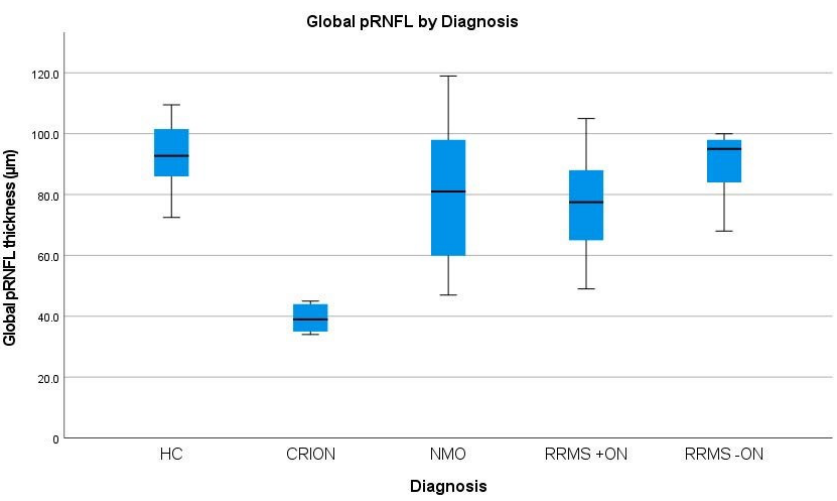
Figure 2. Comparison of all quadrants of pRNFL and PMB thickness between CRION, NMOSD, RRMS with ON, and RRMS without ON, and HC.